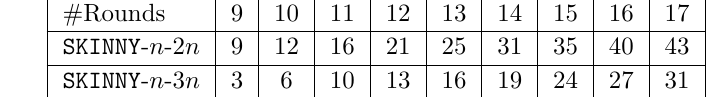
Table 5: Lowerbounds on the number of active S-boxes in SKINNY under the related-tweakey setting [BJK +